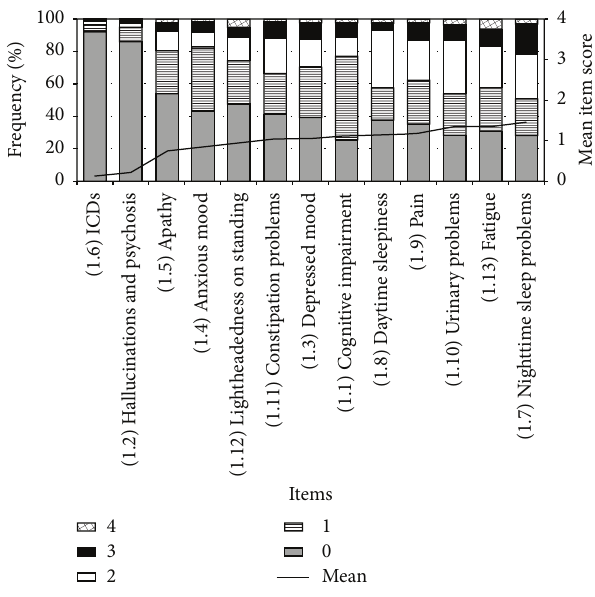
Figure 1: Bar diagram showing the two aspects of the severity of each nonmotor symptom. Firstly, the proportional distribution of responses of MDS-UPDRS Part I for each item is shown in bars. Severity scores range from 0 (symptom is absent) to 4 (symptom is severe). Secondly, the mean scores of each item of MDS-UPDRS Part I are shown by the continuous line, ICDs being with the lowest and nighttime sleep problems with the highest value.